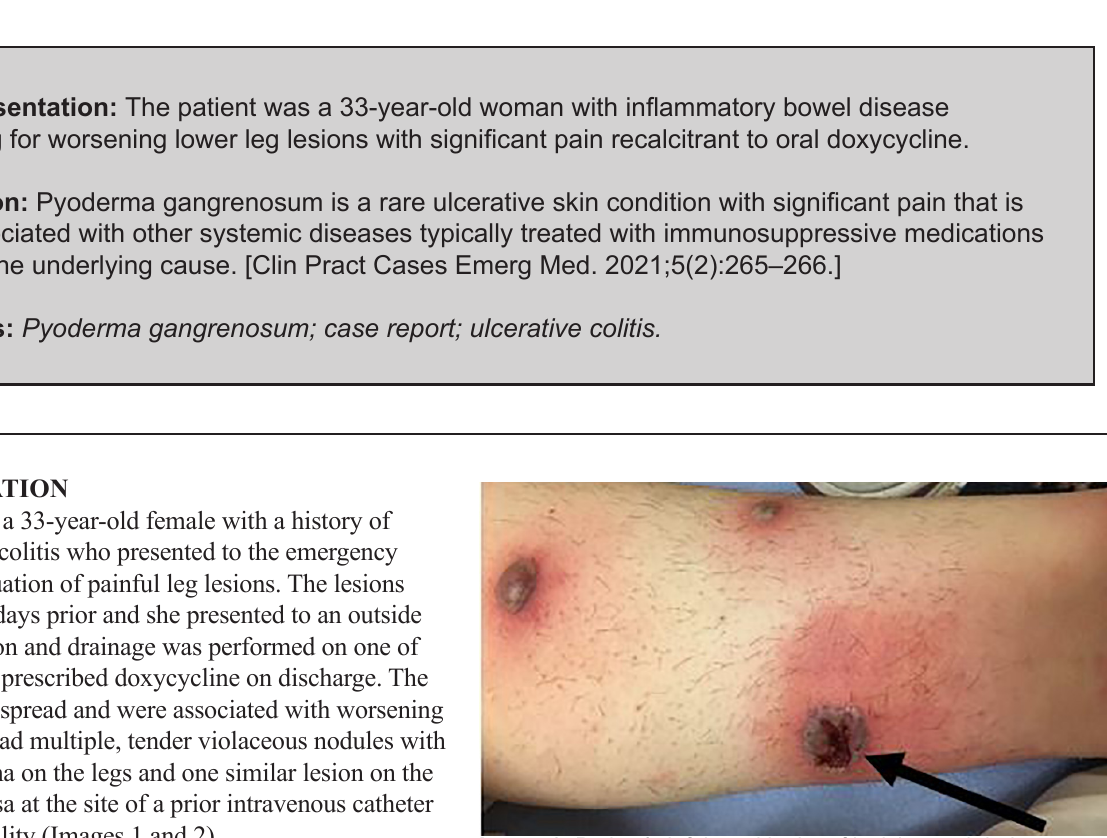
Image 2. Patient’s left leg with site of incision and drainage marked by